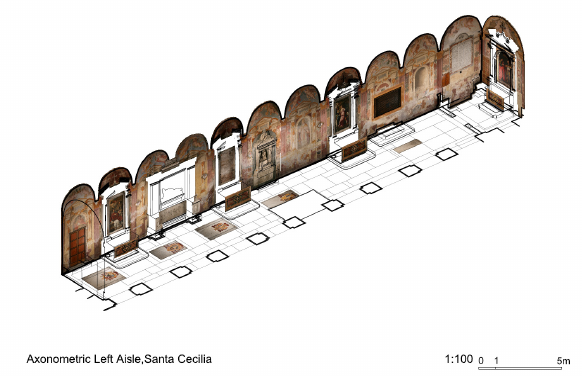
Figure 4. Final product of the ICCROM-GCI training